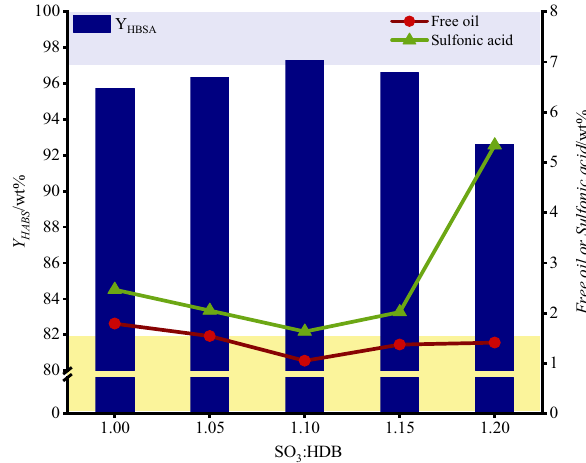
Figure 6: E ff ect of SO 3 :HDB molar ratio on the yield of HBSA, free oil and free sulfonic acid, featuring a reaction temperature of 50°C, SO 3 mass fraction of 10 wt% and residence time of 10.18 s. The pale navy blue parts indicate the range of HBSA content in the superior pro - ducts and the pale yellow parts indicate the range of free oil and sulfonic acid content of the superior products.